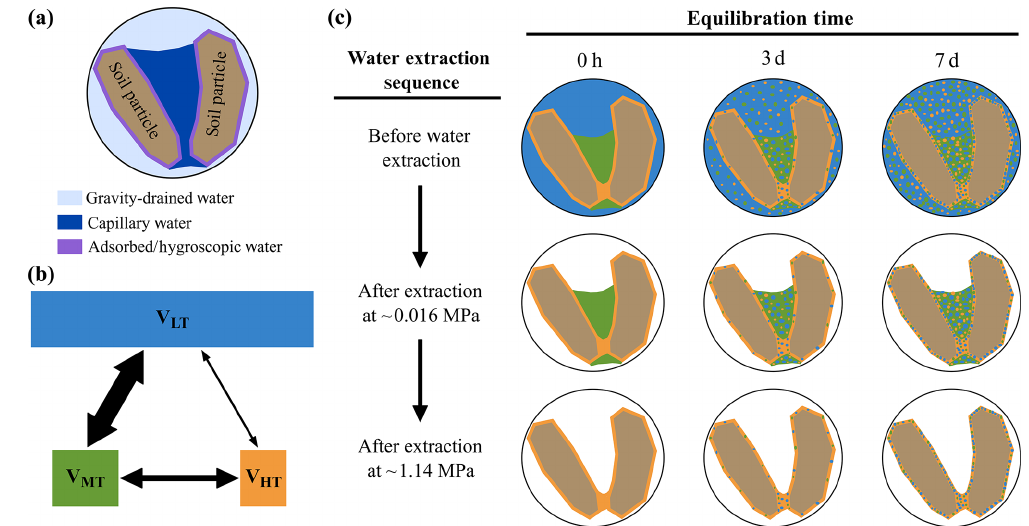
Figure 3. (a) Spatial relationship of the three most commonly discussed water pools that make up the bulk water pool in soil near saturation. Absorbed/hygroscopic water, capillary water, and gravity-drained water are depicted in a hypothetical cross-sectional view of two soil particles within the soil matrix. (b) Relative volumes (V) of soil water pools in this study based on Fig. 1 (“LT” denotes low tension, “MT” denotes mid tension, and “HT” denotes high tension) and the relative amount of interactions (size of black arrows) between pools as equilibration time proceeds. (c) Three soil water pools for this study in hypothetical pore space, as diagramed in panel (a) , at three equilibration time points and various points in the water extraction sequence. Based on Fig. 1, water extracted at low tension is comprised of gravity-drained water and capillary water, water extracted at mid tension is composed of capillary water, and water extracted at high tension is comprised of capillary water and hygroscopic water. As equilibration time increases, each pool moves closer towards a well-mixed state (i.e.,